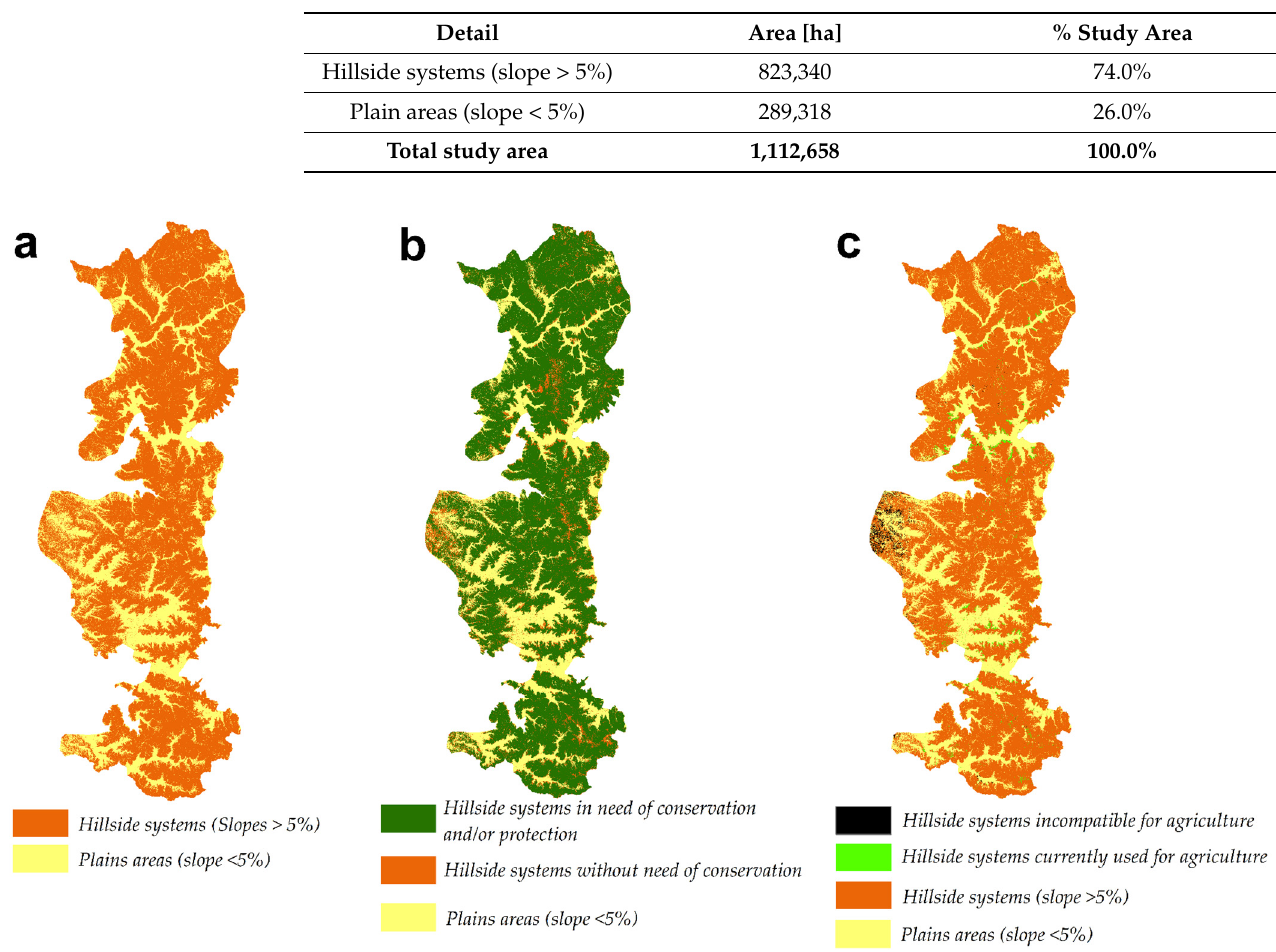
Figure 4. Description of the structure and dominant coverage in the landscape of the coastal mountain range: ( a ) shows the hillside systems and plains areas; ( b ) shows the hillside systems in need of conservation due to their natural vegetation cover and the hillside systems that do not need conservation; ( c ) shows the hillside systems unsuitable (incompatible) for agriculture and those currently used for agriculture. Table 3. Need for conservation of the hillside systems (Figure